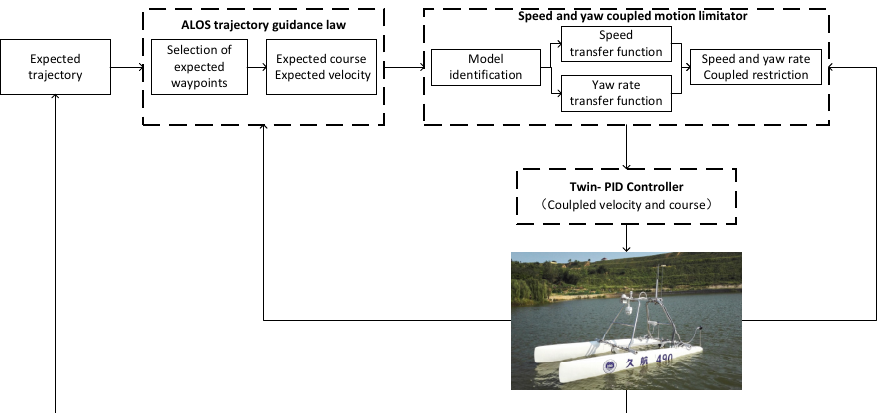
Figure 2. The proposed practical trajectory tracking of the USV under three-layered architecture.